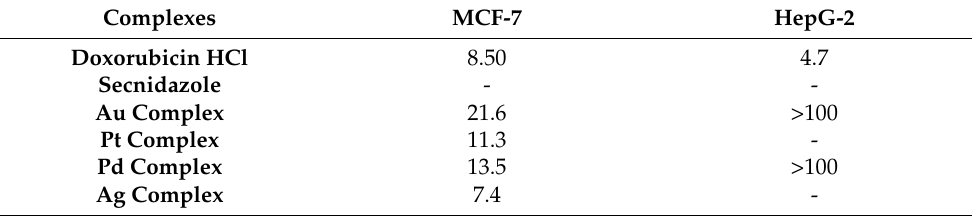
Table 5. IC50 ( µ g/mL) values of the four complexes against MCF-7 and HepG-2 cell lines. Complexes